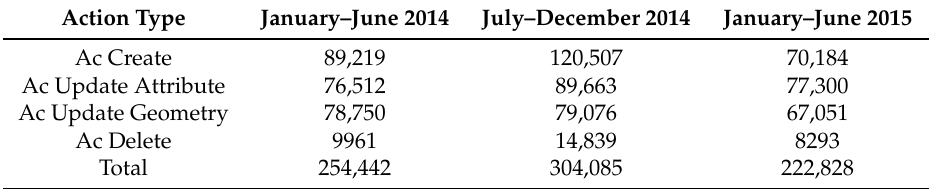
Table 8. Number of actions per action type during six-month periods for the city of Berlin.